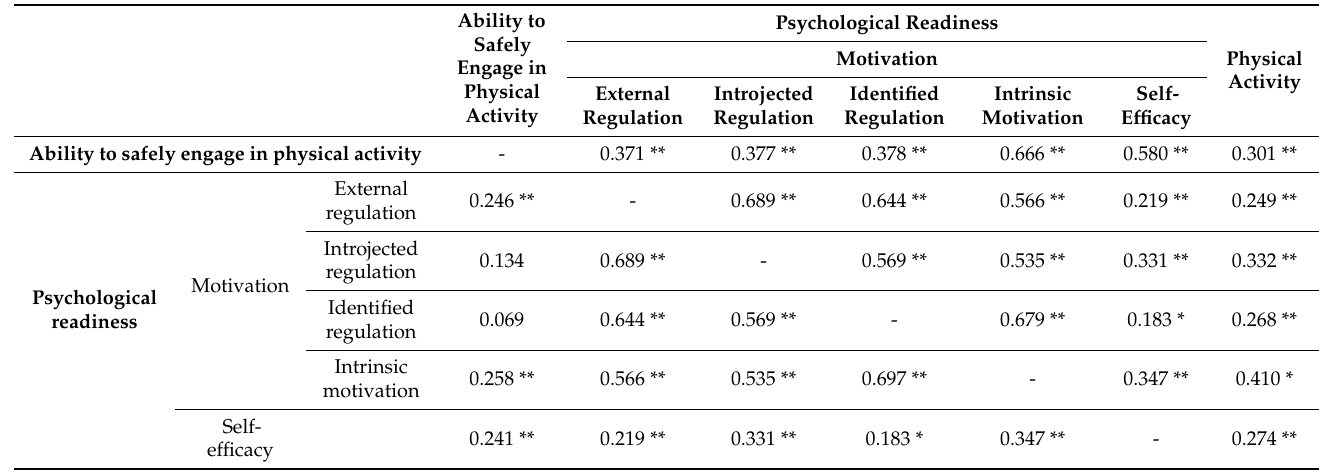
Table 2. Correlations between physical readiness and psychological readiness.